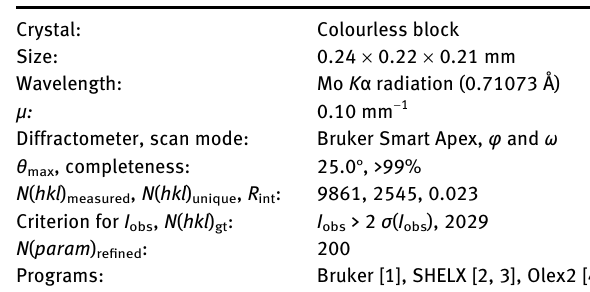
Table  : Data collection and